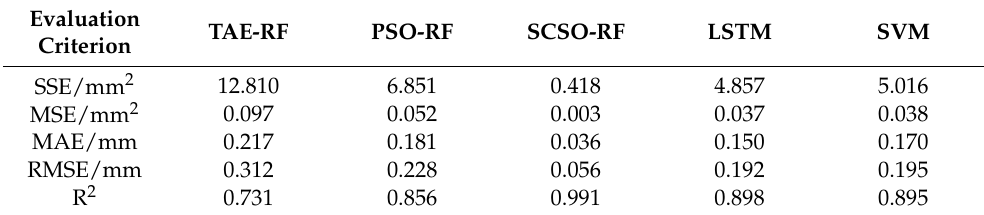
Table 3. Comparison of prediction performance of